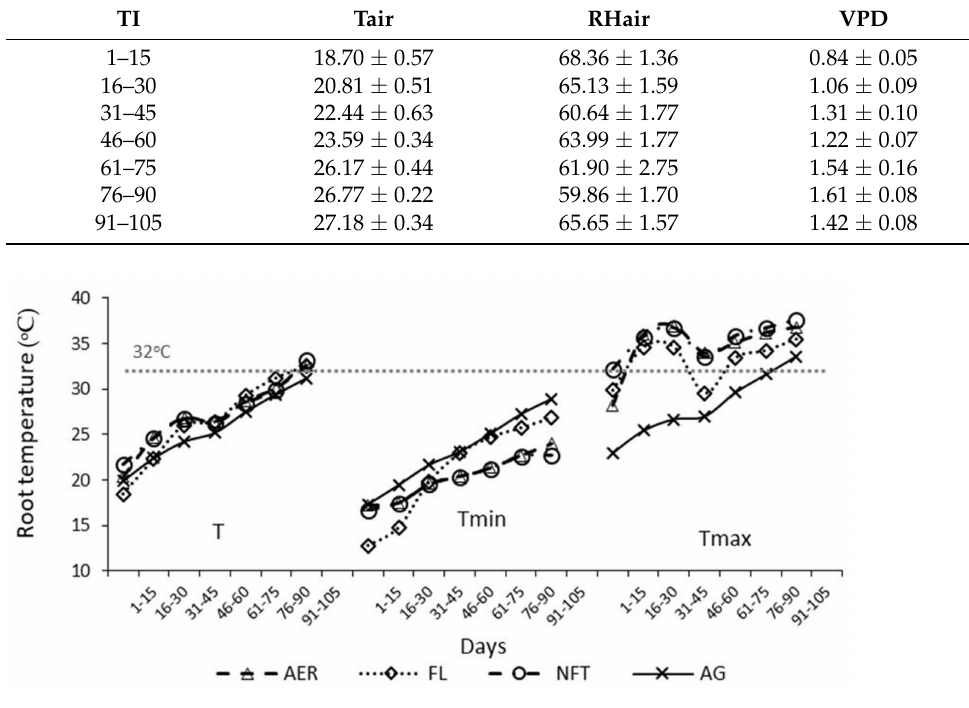
Figure 2. Temperature ( ◦ C) in the root zone of the compared CSCS at time intervals (TI) of 15 days from transplant. (I) Mean, (II) Mean minimum, (III) Mean maximum